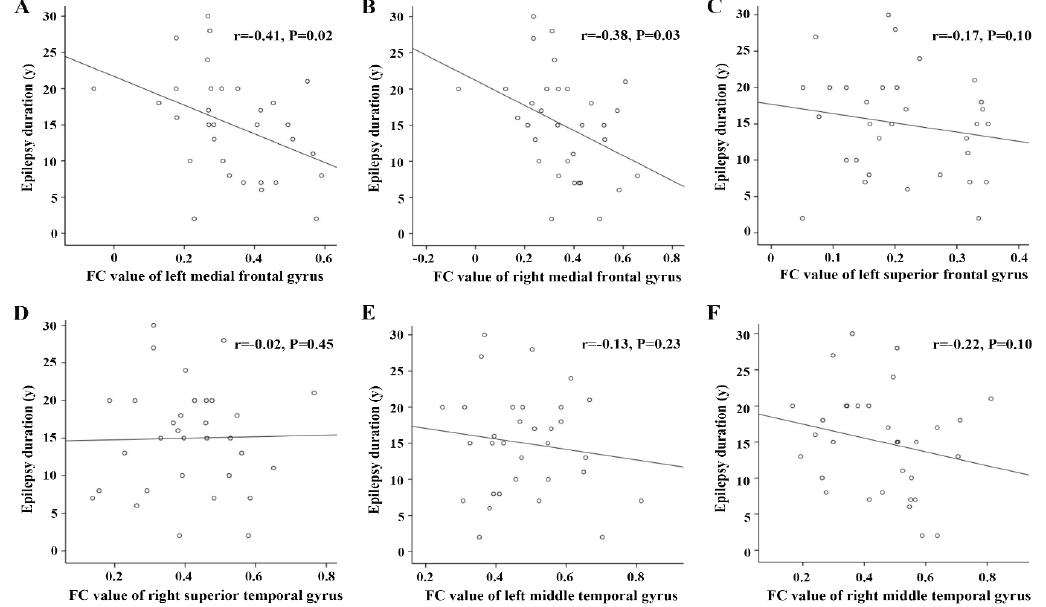
Figure 4. Correlations between epilepsy duration and FC values of brain areas showing decreased connection with hypometabolic ROI. FC values of left ( A ) and right ( B ) medial frontal gyri negatively correlated with the year of epilepsy duration in patients with TLE. There were no relationships between the FC values of other brain regions and epilepsy duration ( C – F ).